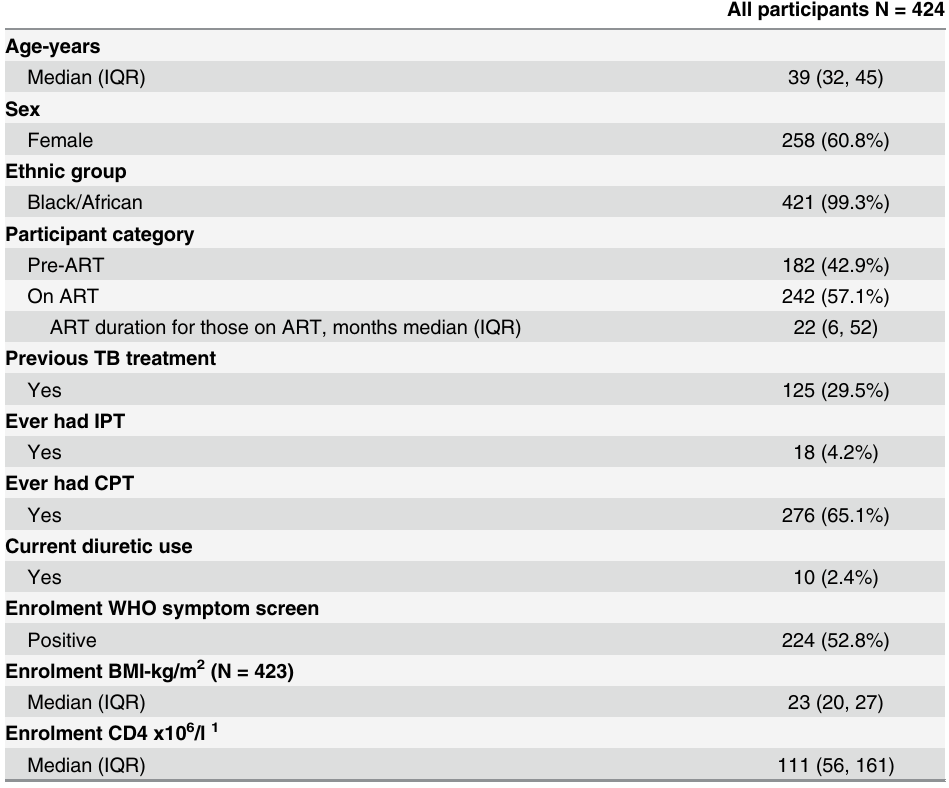
Table 1. Baseline characteristics of study